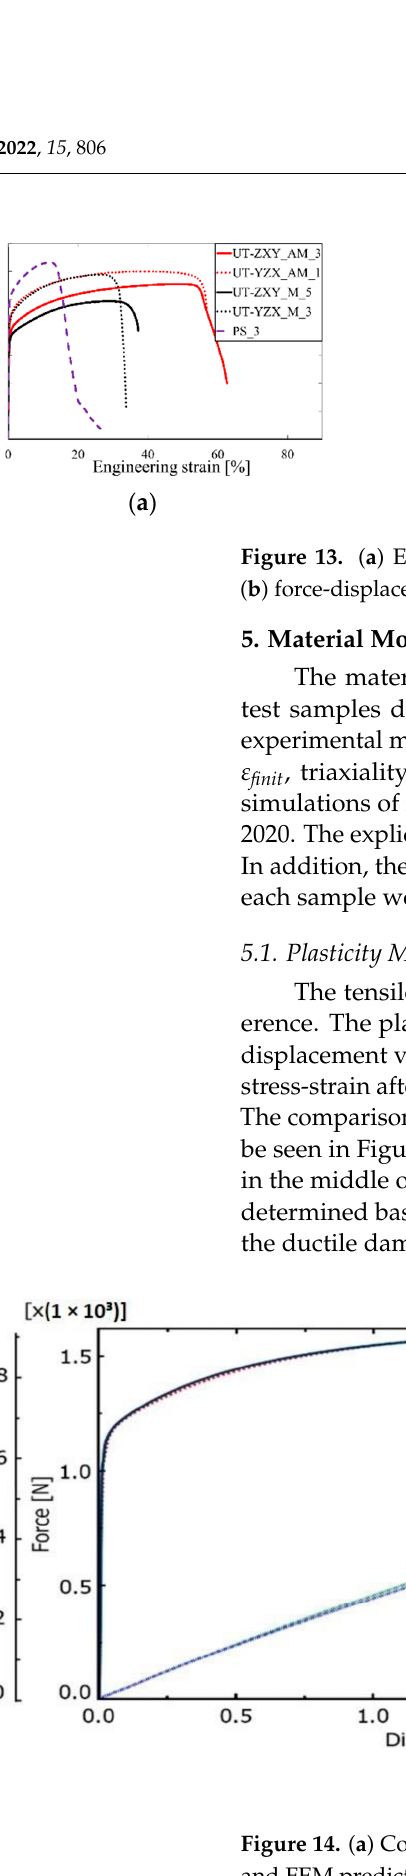
( c ) Figure 12. Geometries in millimeter of the samples designed in SolidWorks software extracted from DED-processed honeycomb structures employed in ( a ) plane strain test (PS), ( b ) compression test (CT) and ( c ) biaxial test (BT).